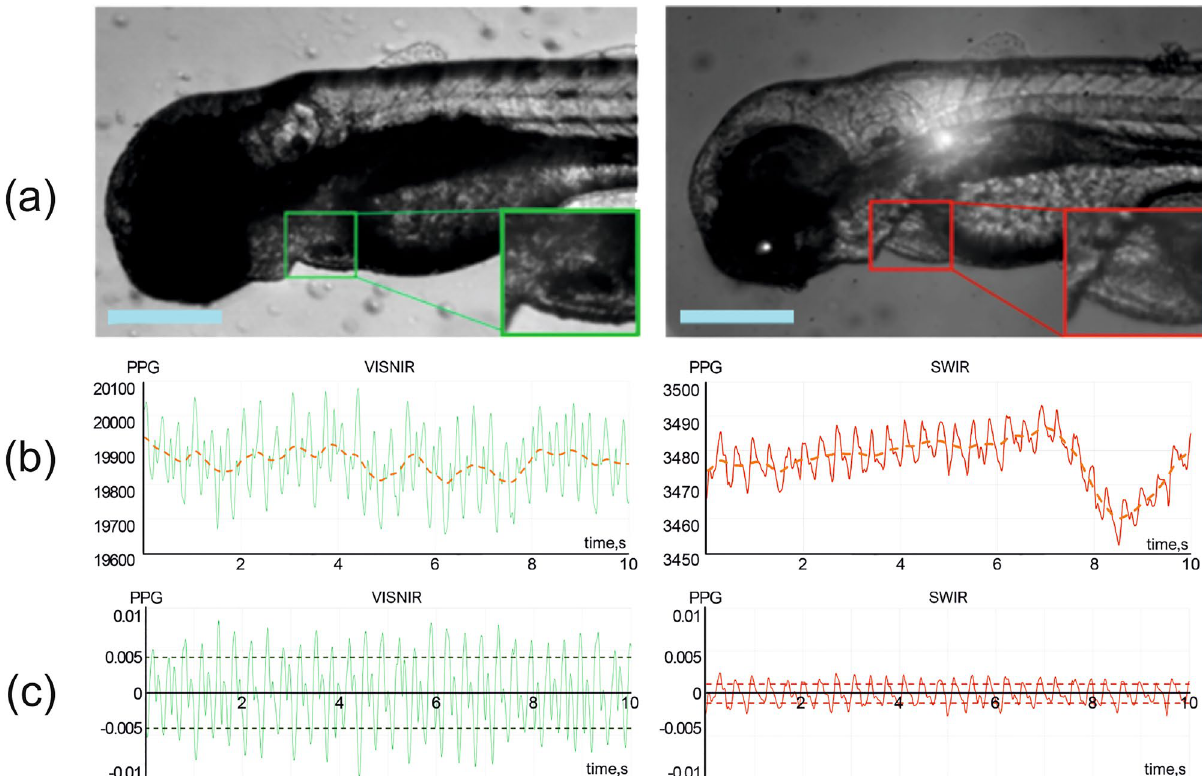
Figure 5. Raw images ( a ), initial ( b ), and normalized ( c ) PPG signals in the selected heart area in VISNIR (left) and SWIR (right). Scale bar: 0.5 mm. Dashed lines indicate the averaged PPG signal ( b ) and its root mean square values ( c